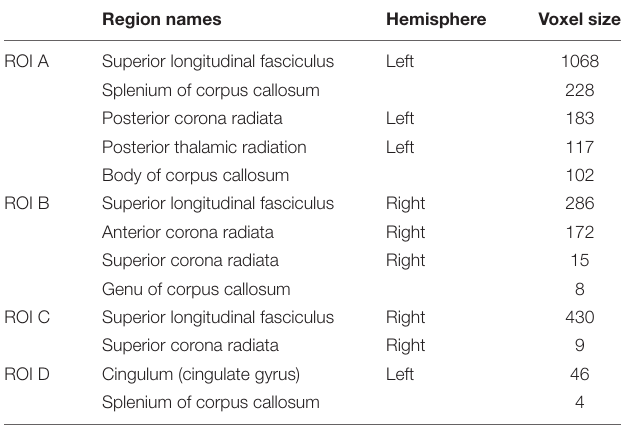
TABLE 2 | Regions showing group differences in local diffusion